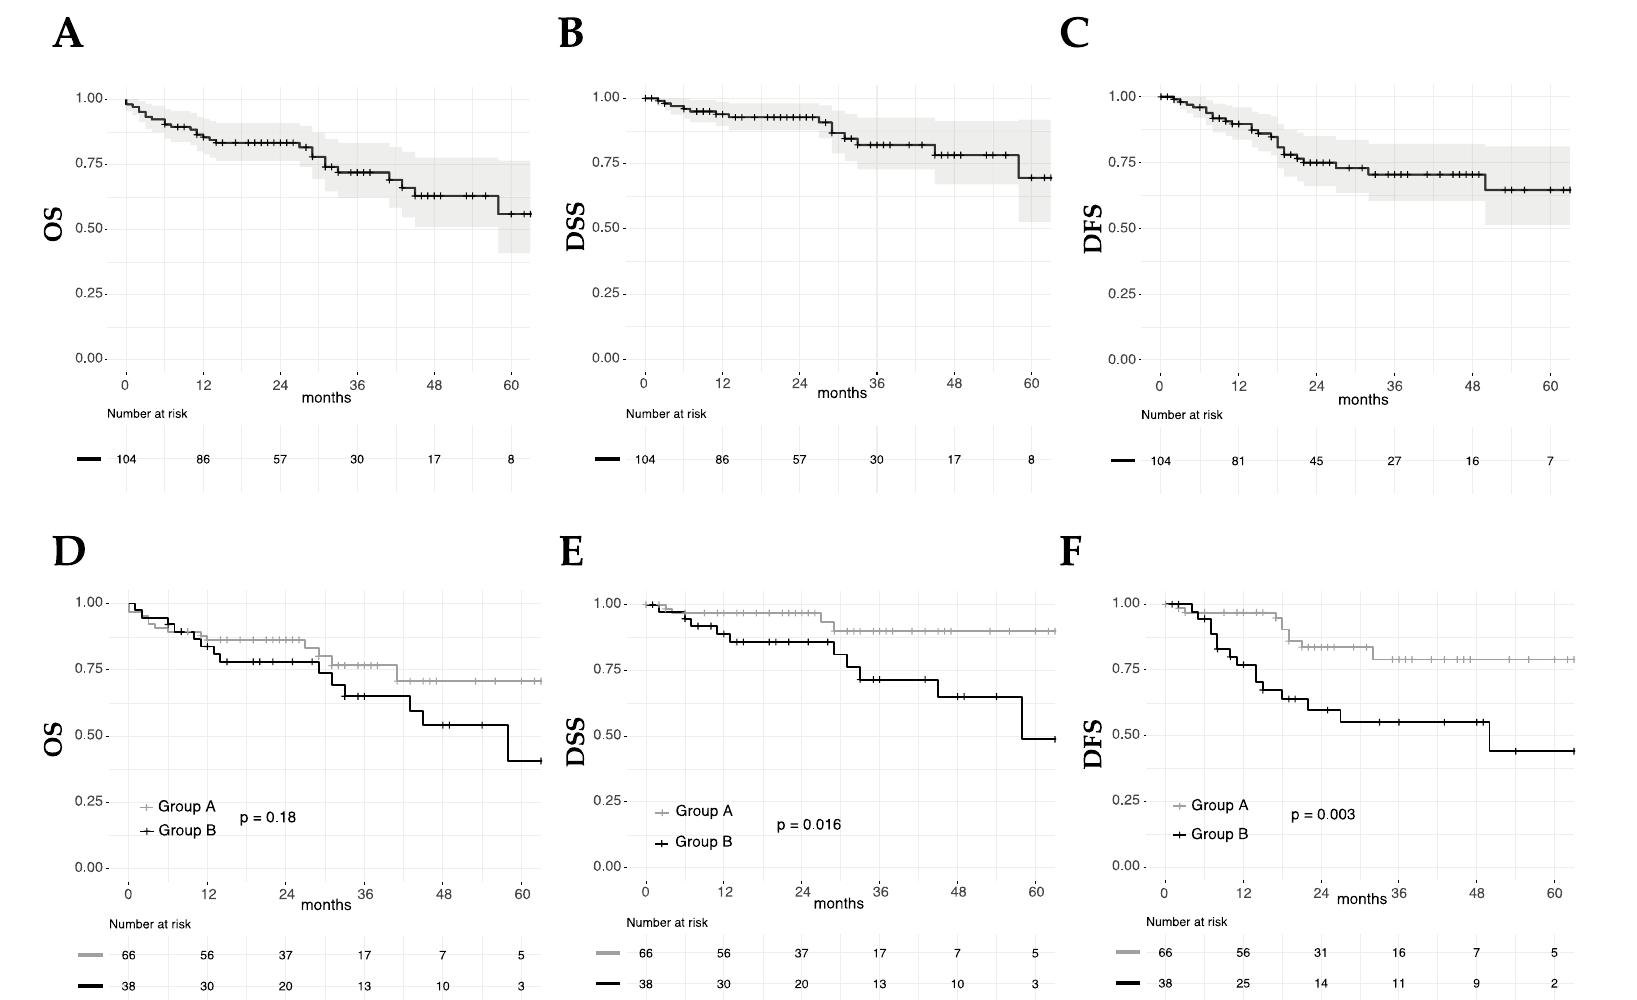
Figure 3. Overall (OS), disease-specific (DSS), and disease-free survival (DFS) for the entire cohort ( A , B , C ) and for Groups A and B ( D , E , F ); p values estimated by a log-rank test.